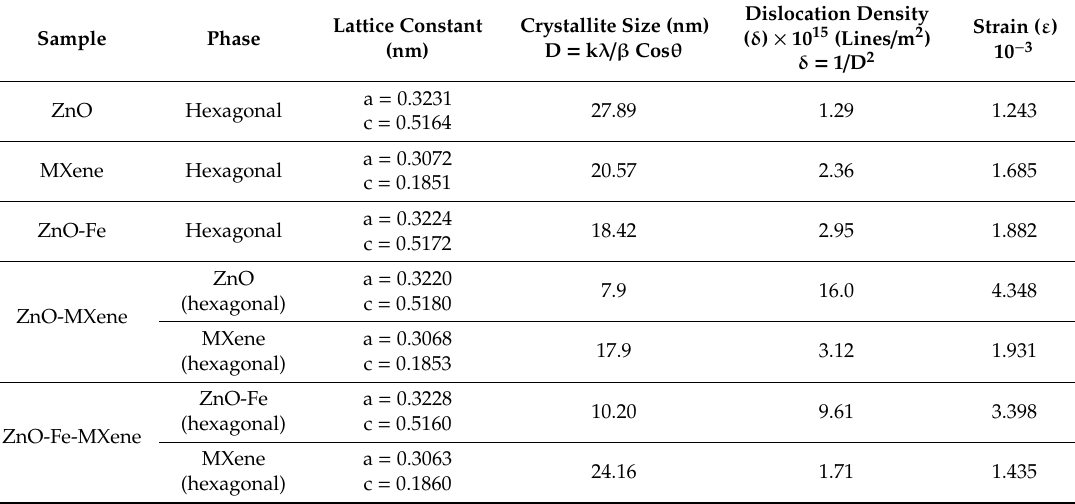
Figure 1. ( a ) XRD pattern; ( b ) FTIR spectra of the ZnO, MXene, ZnO-Fe, ZnO-MXene, and ZnO-Fe-MXene nanocomposites. Table 1. Lattice parameters obtained from the ZnO, MXene, ZnO-Fe, ZnO-MXene, and ZnO-Fe-MXene nanocomposites.